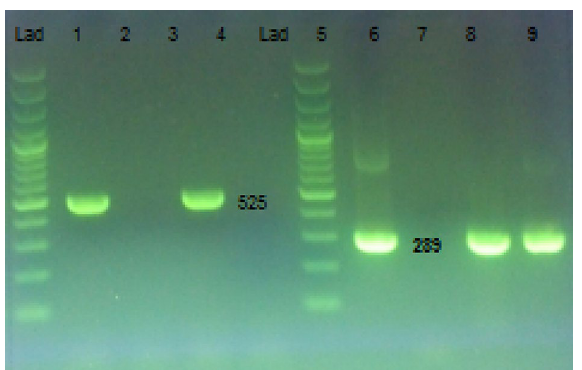
Figure 1. Amplified products from nested PCR of genomic DNA of Leptospira interrogans in urine samples. Molecular marker of 100 bp ladder, Lane 1: Positive control 525 bp, Lane 2: Negative control, Lane 3: